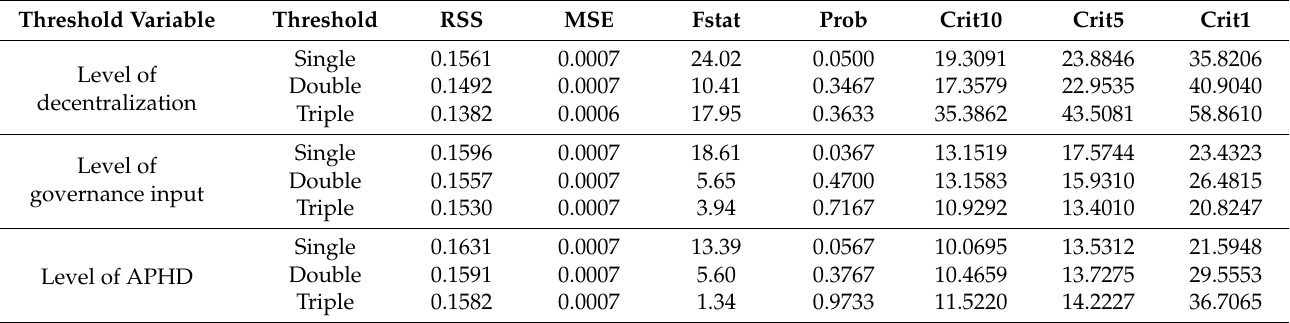
Table 5. Identification results by threshold number.